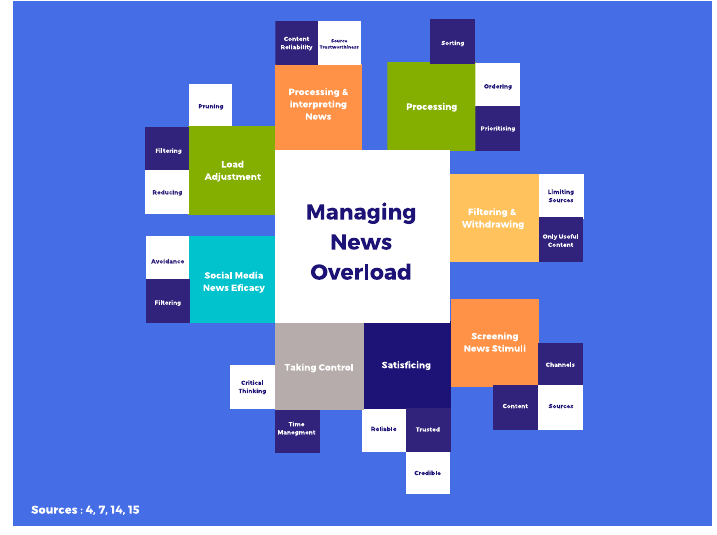
Figure 1. Strategies for managing news overload.